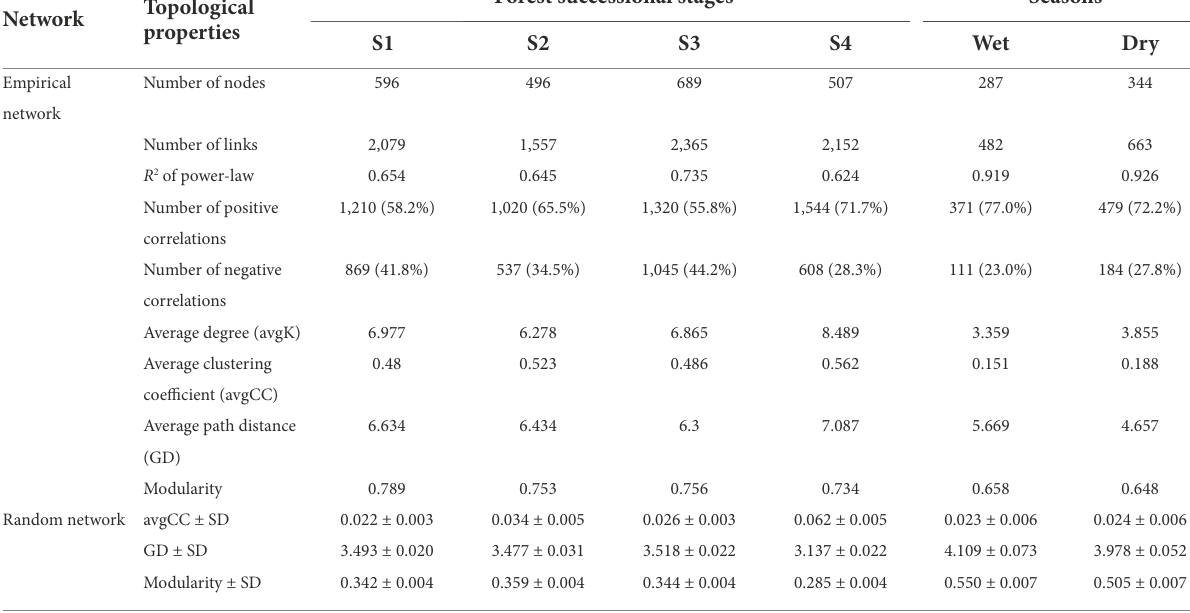
TABLE 3 Topological properties of the taxonomic network in soil